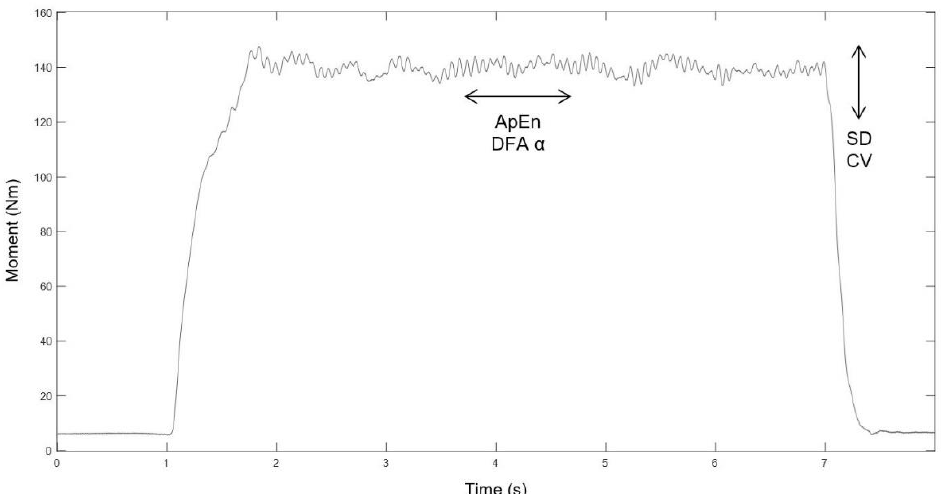
Figure 1. Illustration of how variability-based (magnitude-domain, y -axis) and complexity-based (time-domain, x -axis) variables relate to the graphical plot of an isometric knee extension signal. Nm = Newton-meters; s = seconds; SD = standard deviation; CV = coefficient of variation; ApEn = approximate entropy; DFA α = detrended fluctuation analysis α. See Methods for explanation of ApEn and DFA α.